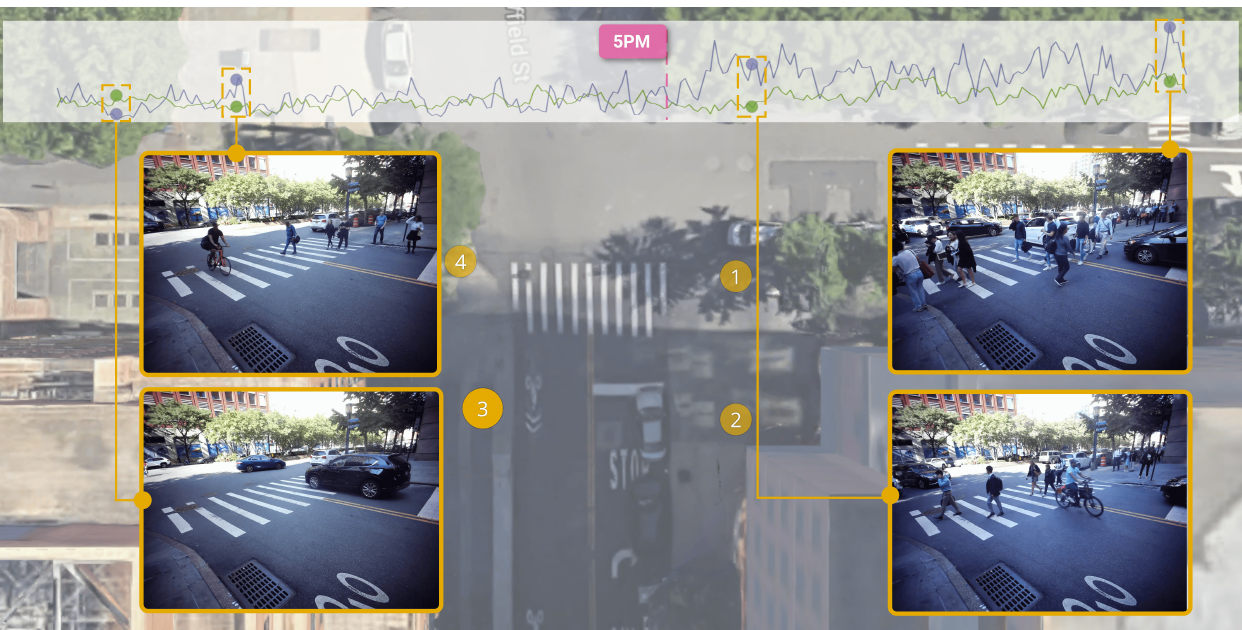
Figure 13. Chase Center intersection occupancy by object type during a recording session in the afternoon, with purple lines representing people and green lines representing cars on the top chart. In the figure, the four sensors collecting data during this session are represented by circles. There is a significant ( ≈ 3 × ) increase in the pedestrian count (blue) around 5 p.m. as people leave work. Moreover, it is possible to detect traffic light cycles based on the ratio of the number of pedestrians versus vehicle